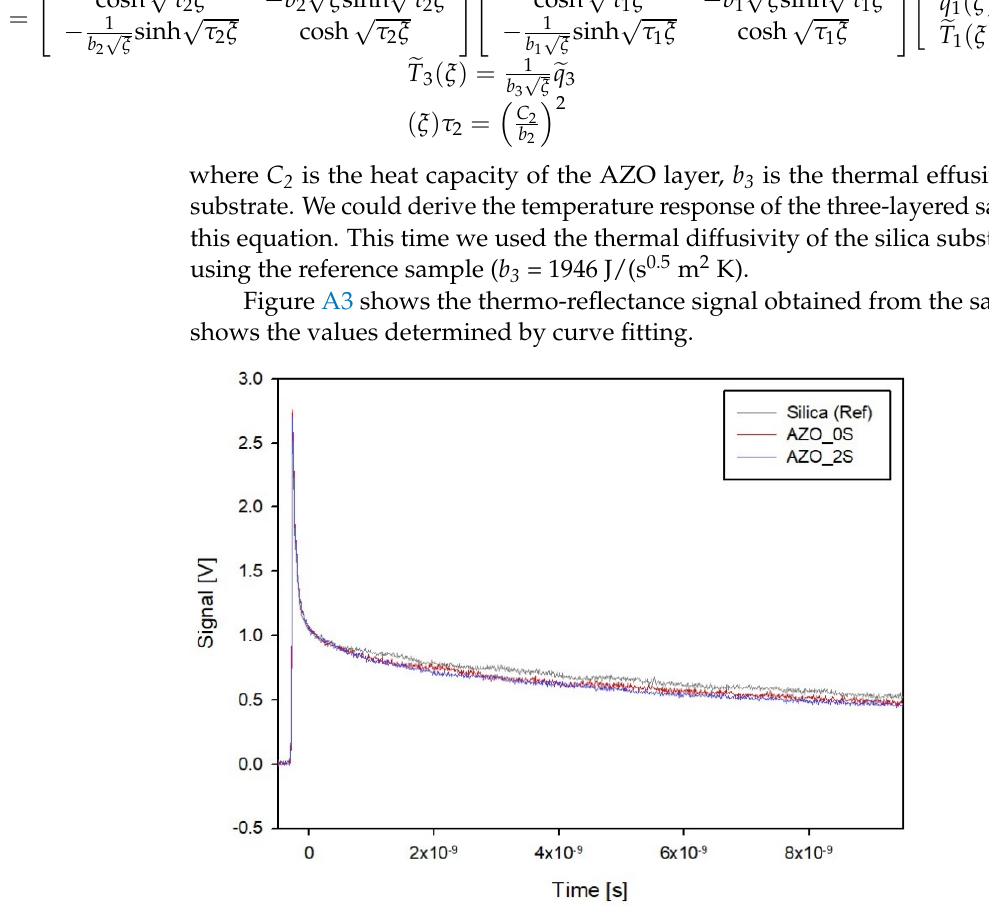
Figure A3. Thermo-reflectance signals of the silica reference and AZO samples. Table A1. Thermal properties of samples AZO_0S and AZO_2S.